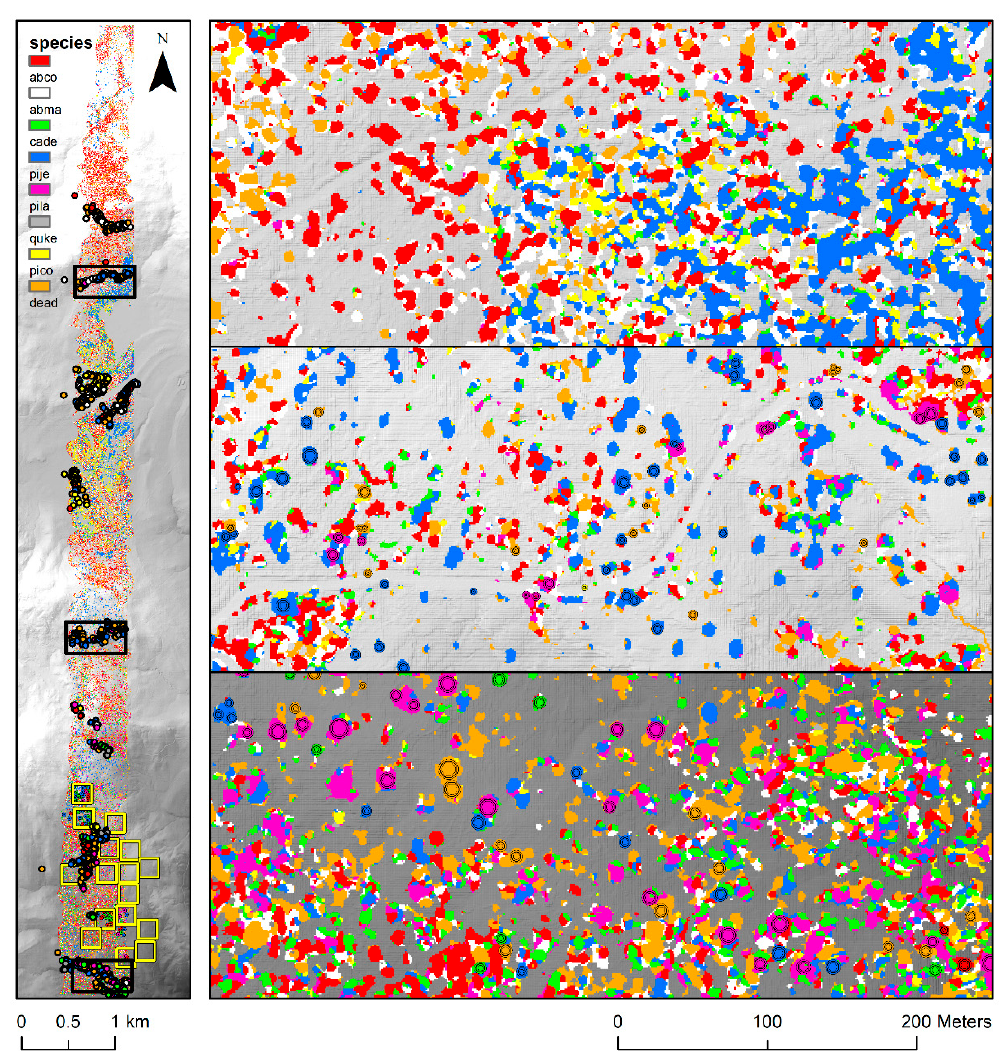
Figure 4. Full flight line strip showing hyperspectral CNN predicted species as colors on a hill shade digital elevation model (left), Field GPS points are represented as points (left) and circular polygons (right) and CNN model prediction results are represented as the colorized raster image for three sections at high, mid, and lower elevation sites.